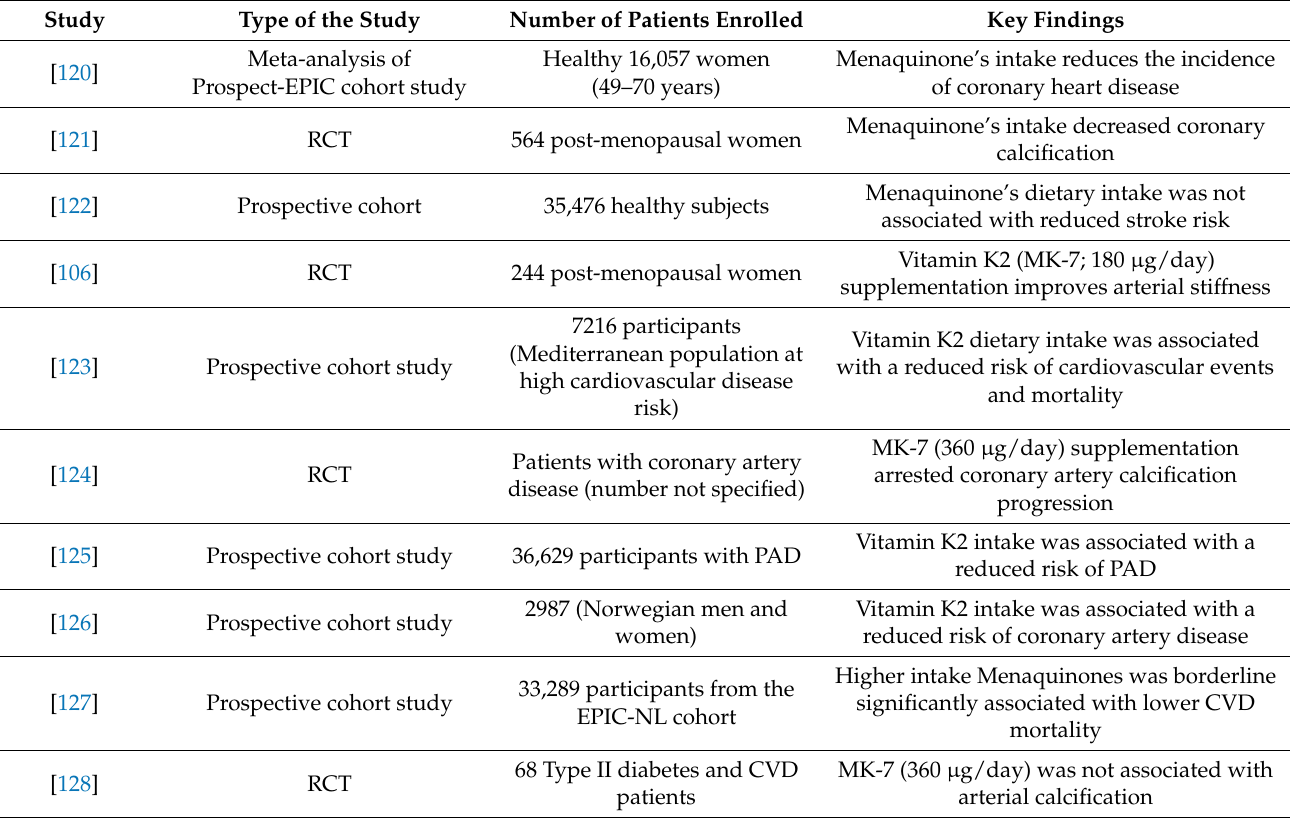
Table 3. Clinical evidence linking vitamin K2 supplementation and vascular